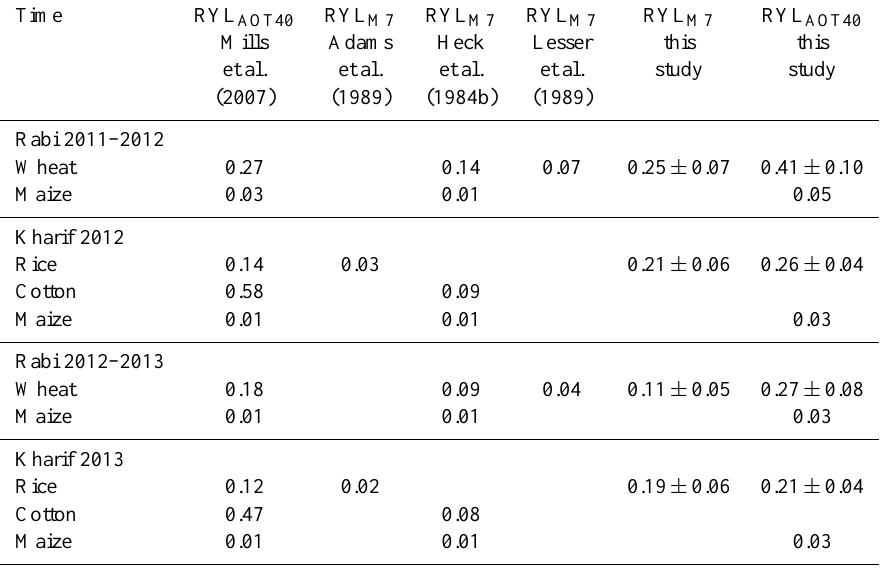
Table 9. Relative yield losses calculated according to different ozone exposure–response relationships for rice, wheat cotton and maize. Time RYL AOT40 RYL